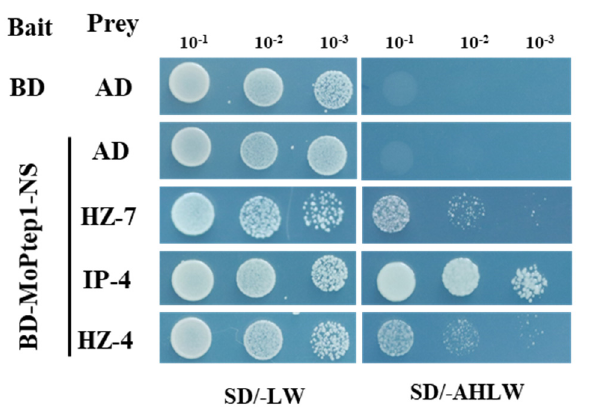
Figure 8. Verification of protein interactions in yeast. Analysis of protein–protein interactions between BD-MoPtep1-NS and AD-OsHZ-7, AD-OsIP-4, AD-OsHZ-4 via yeast-two-hybrid (Y2H) assay. Yeast transformants were diluted 10 − 1 , 10 − 2 , 10 − 3 and spotted onto selective media SD/-Trp/-Leu (SD-LW) and SD/-Trp/-Leu/-His/-Ade (SD-AHLW). Photographs were taken after incubation at 28 ◦ C for 3